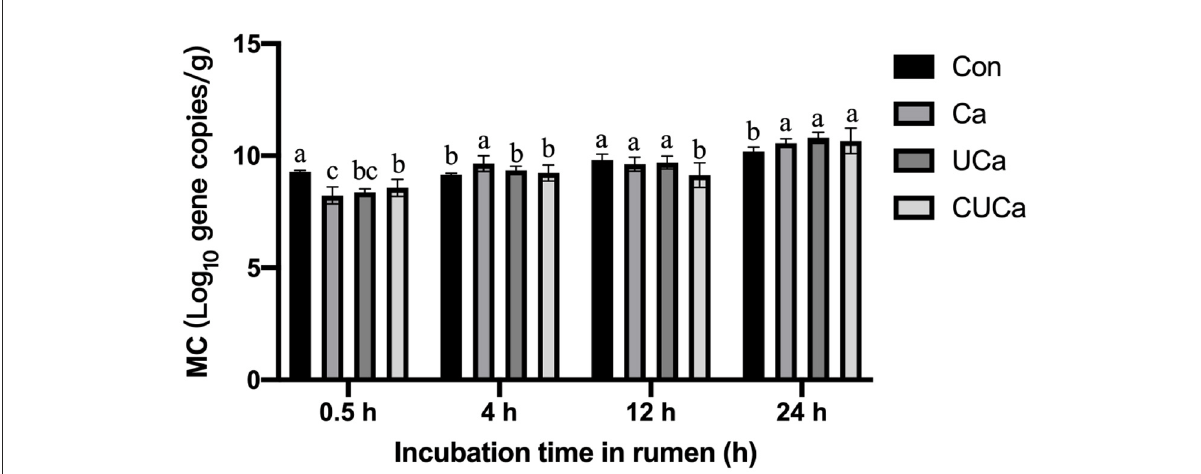
FIGURE6 Microbial colonization (MC) (log 10 gene copies/g of undigested rice straw) of rice straw following incubation for up to 24h. Con: no pretreatment for control group, Ca: 4% CaO, UCa: 2.5% urea + 4% CaO, CUCa: 9% CSL + 2.5% urea + 4% CaO. Different superscript letters a, b, and c indicates significantly different values ( P < 0.05) in different groups, and the same or no letters indicate insignificant differences ( P > 0.05).